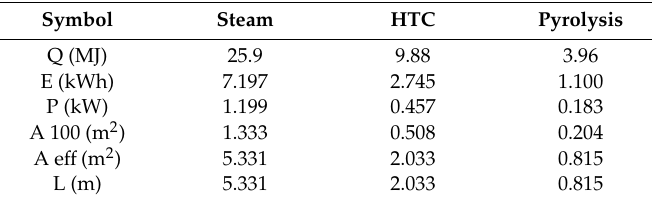
Table 4. Results of the example energy demand simulation.